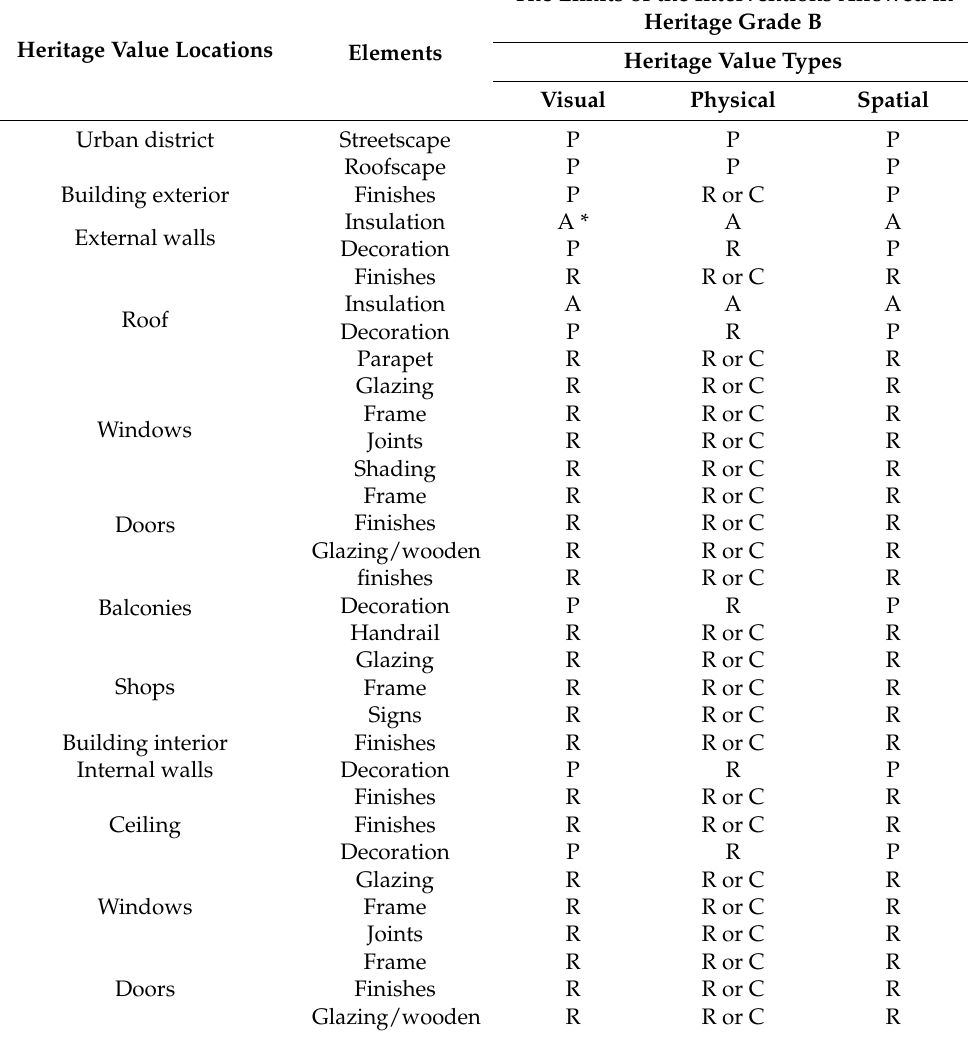
Table A3. Checklist of sustainable retrofitting scenarios for heritage Grade (B) in the Egyptian context, based on